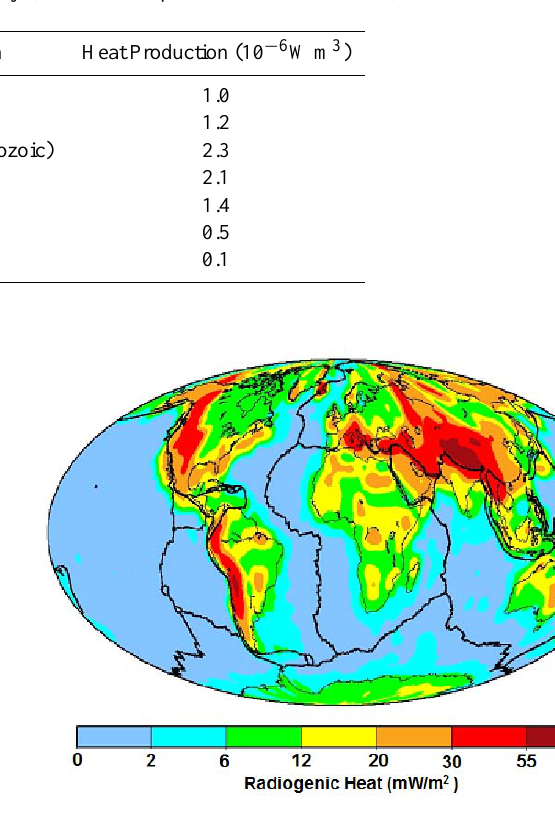
Fig. 6. Global map of heat flux produced by radiogenic elements in the Earth’s crust, based on the crustal structure data set of Mooney et al., (1998) and the empirical relation between seismic veloc- ity and heat production (Rybach and Buntebarth, 1984). Note the sharp contrast in heat production between continental and oceanic